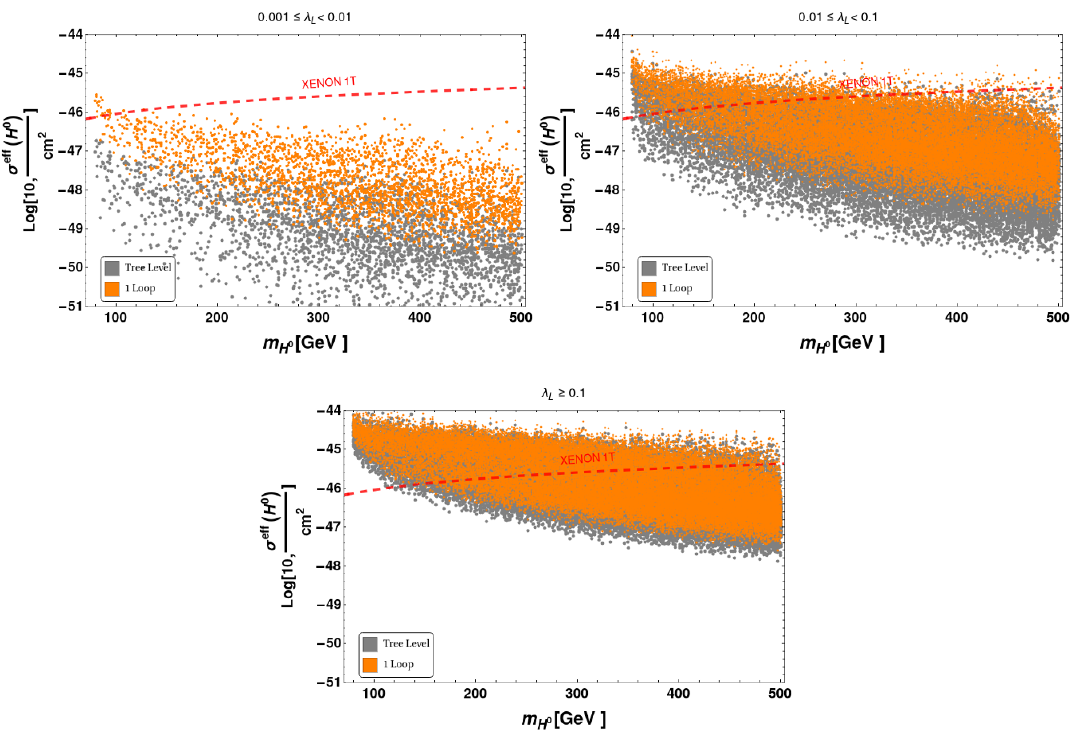
Figure 13 . SI Direct detection cross section for IDM component is plotted against m left) 0 : 001 . (cid:21) L < 0 : 01, (upper right) 0 : 01 . (cid:21) L < 0 : 1 and (bottom) (cid:21) L & 0 : 1. All the (cid:12)gures show (cid:27) e(cid:11) both at tree level (light black) and at NLO level (orange). The XENON 2018 bound (red H 0 dotted line) is shown for comparison purpose.